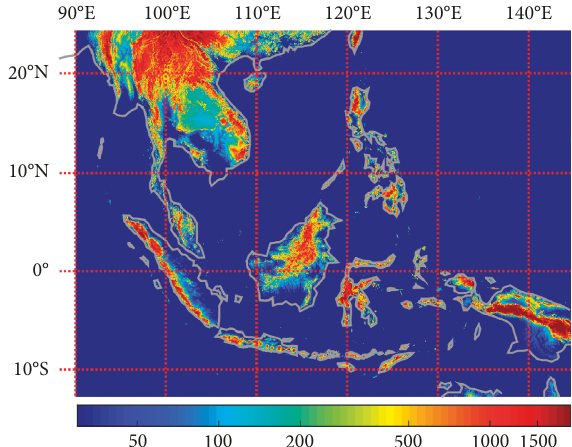
Figure 1: Topography (m) above the mean sea level of Southeast Asia, the study